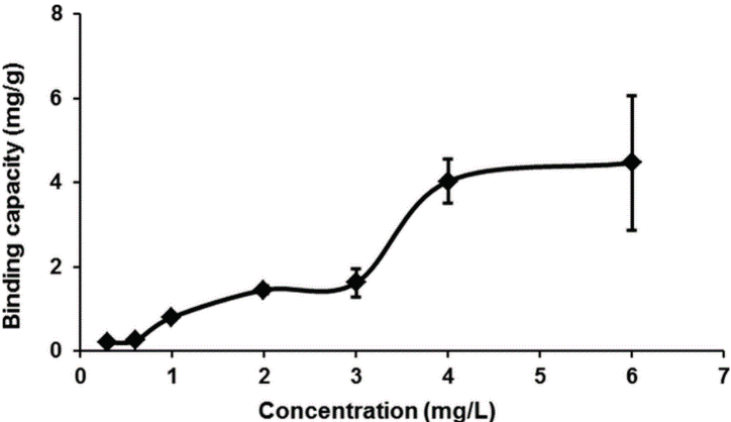
Figure 6. Effect of equilibrium Hg(II) concentration on the adsorption of Hg(II) ions on MIP (conditions: total volume of 10 mL, 10 mg of MIP beads, pH 7, temperature 25 °C, contact time 10